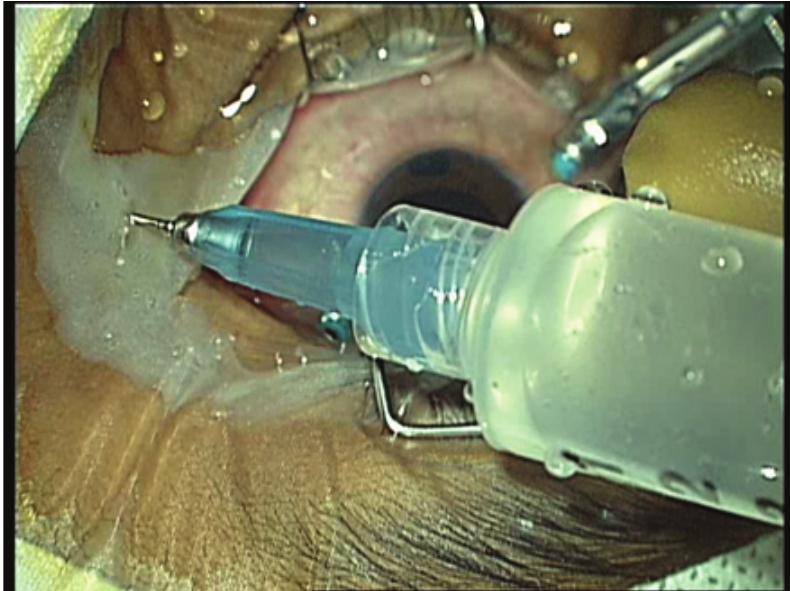
Figure 1. Opaque silicone oil intermixed with infusion fluid in extraction syringe intraoperatively.